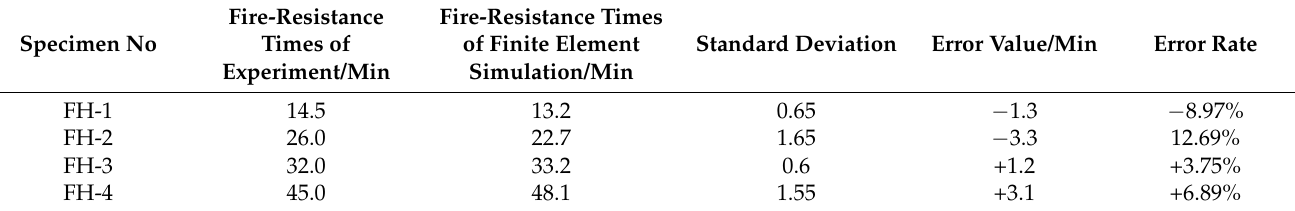
Figure 15. Comparison between finite element simulation and test results of fire resistance of high ‐ silica needled felt. Table 6. Errors between test and simulation results of fire resistance times of high ‐ silica needled felt.